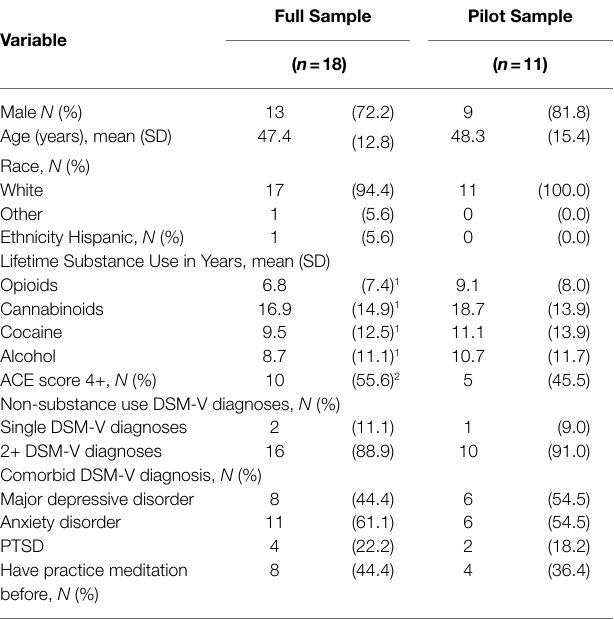
TABLE 2 | Demographic/baseline